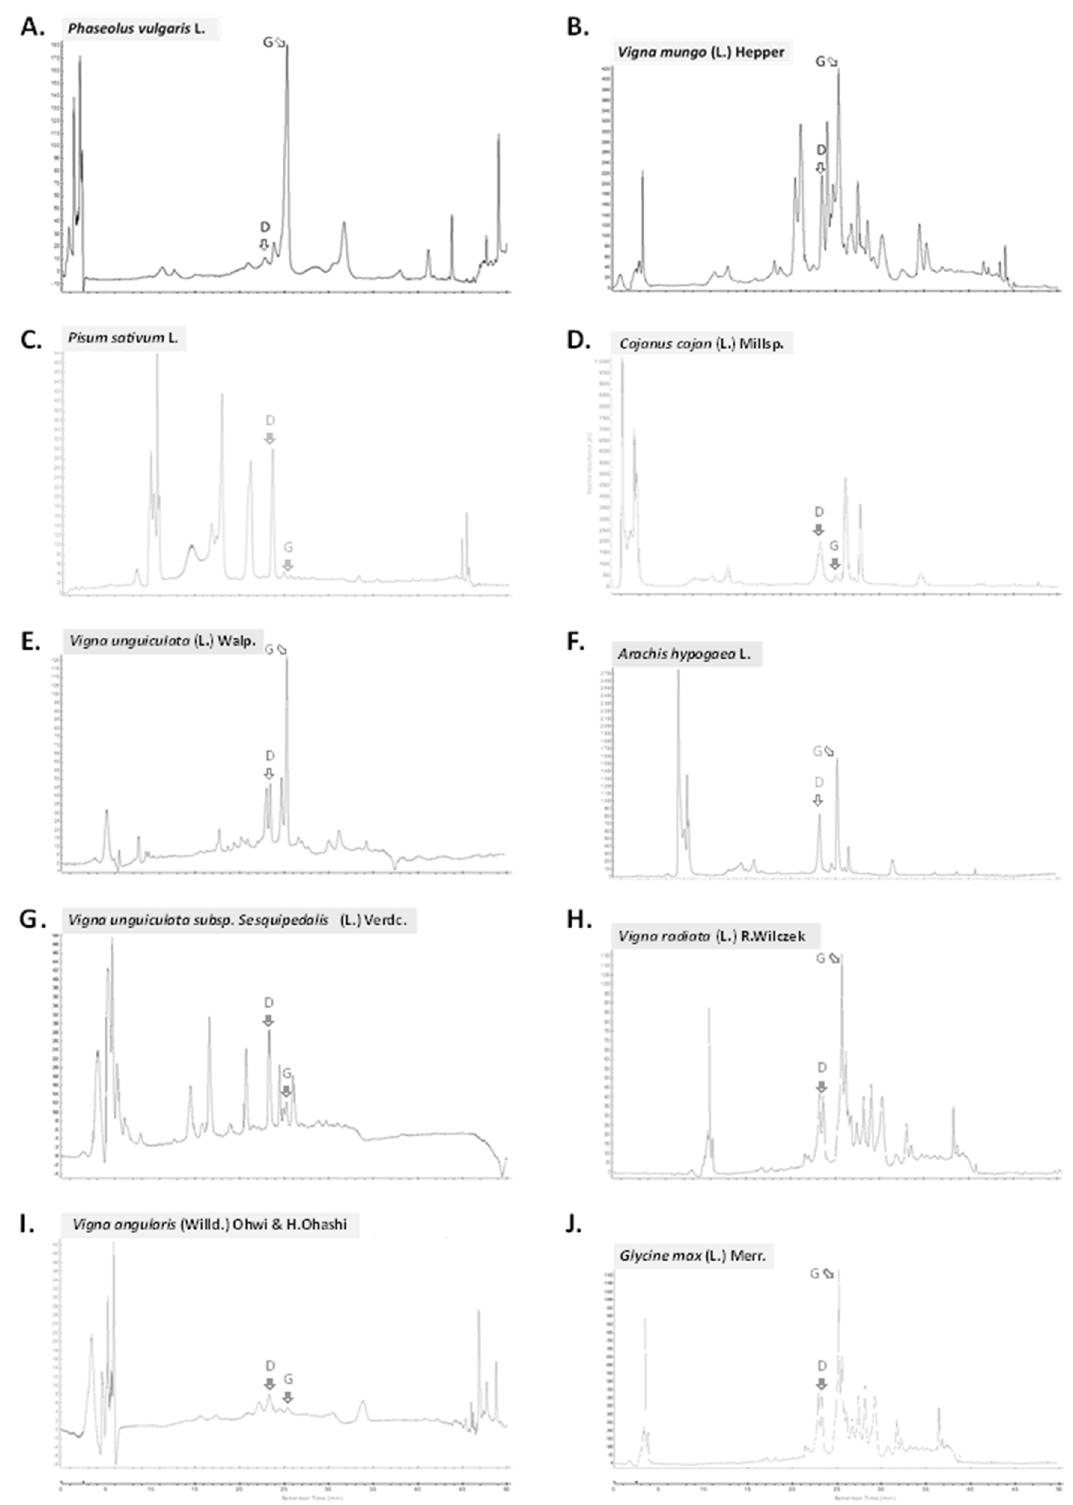
Figure 2. HPLC chromatograms (at 260 nm) of the 10 collected seeds of edible Fabaceae taxa in Thailand: ( A ) P . vulgaris from Chiang Mai; ( B ) V . mungo from Sukhothai; ( C ) P . sativum from Lampang; ( D ) C . cajan from Chumphon; ( E ) V . unguiculata from Chainat; ( F ) A . hypogaea from Surin; ( G ) V . unguiculata subsp. sesquipedalis from Chiang Mai; ( H ) V . radiata from Nakhon Sawan; ( I ) V . angularis from Phetchaburi; ( J ) G . max from Kalasin; D: daidzein; G: genistein.